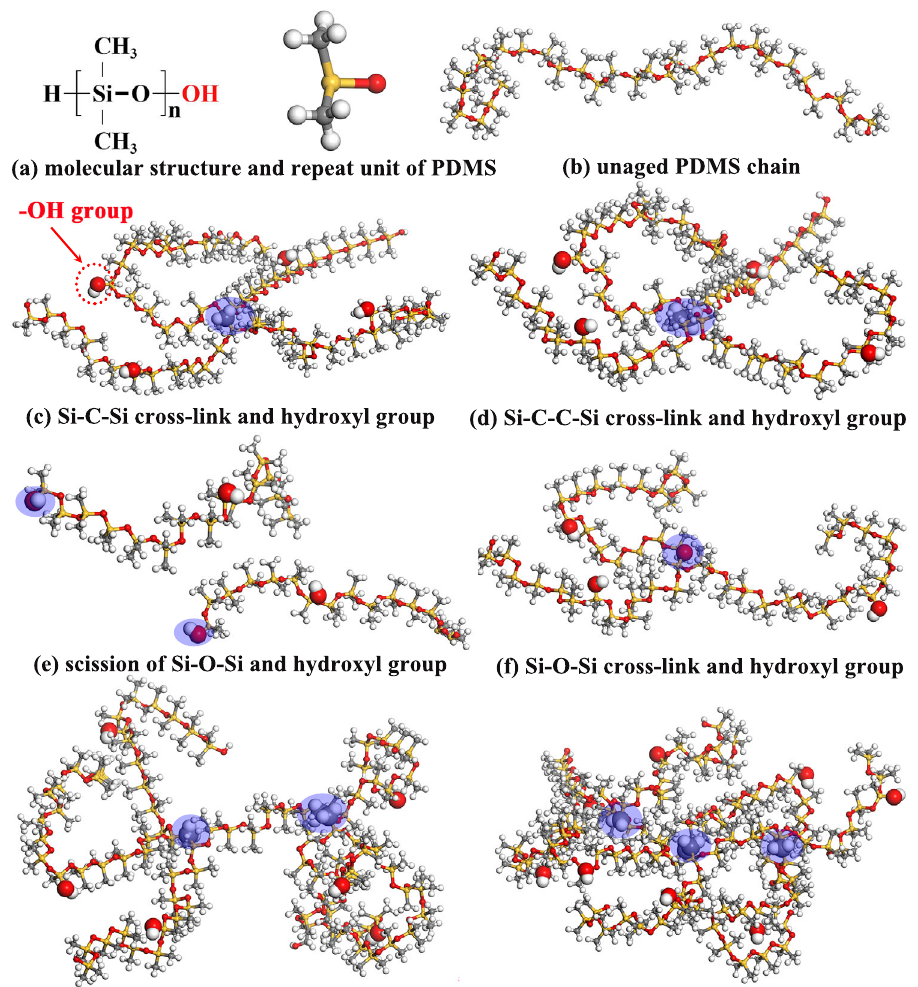
Fig. 15 The chemical structures of the unaged and aged PDMS chains. a Molecular structure and repeat unit of PDMS, ( b ) unaged PDMS chain (A), ( c ) aged chain B with one Si-C-Si cross-link and four hydroxyl groups, ( d ) aged chain C with one Si-C-C-Si cross-link and four hydroxyl groups, ( e ) scission chain D 1 and D 2 of Si-O-Si main chain with two hydroxyl groups, ( f ) cross-linking structure (E) after scission chain with three hydroxyl groups, ( g ) cross-linking structure (F) with one Si-C-Si cross-link, one Si-C-C-Si cross-link, and six hydroxyl groups, and ( h ) cross- linking structure (G) with two Si-C-Si cross-links, one Si-C-C-Si cross-link, and eight hydroxyl